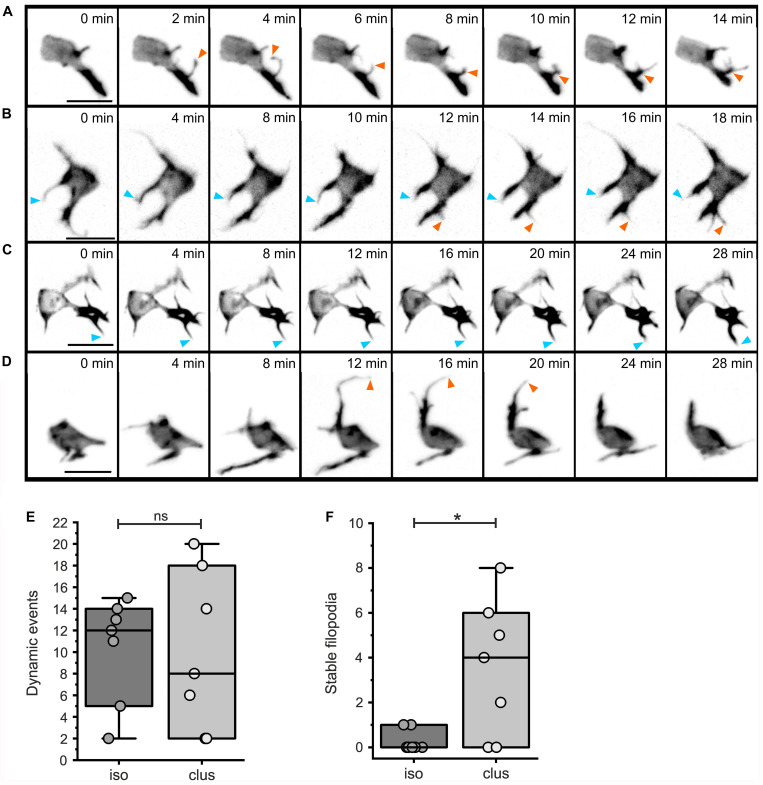
Dynamic protrusive activity of both isolated and clustered cells. Analysis of filopodial dynamics from time lapse series of mosaically labeled secondary islet cells (as in Figure 7; for details see Materials and Methods and Supplementary Tables S2, S5). Z-projections of 3D confocal time-lapse sequences captured at the times indicated, showing isolated (A,B) or more clustered (C,D) cells. Stable (blue arrowheads), and dynamic (orange arrowheads) protrusions are indicated. Dynamic events were equally frequent in isolated as compared to clustered cells (E, p = 0.93), while clustered cells show an increased number of stable filopodia (F, p = 0.016; see Supplementary Table S6). *p < 0.05; ns, not significant. Scale bars, 10 μm.